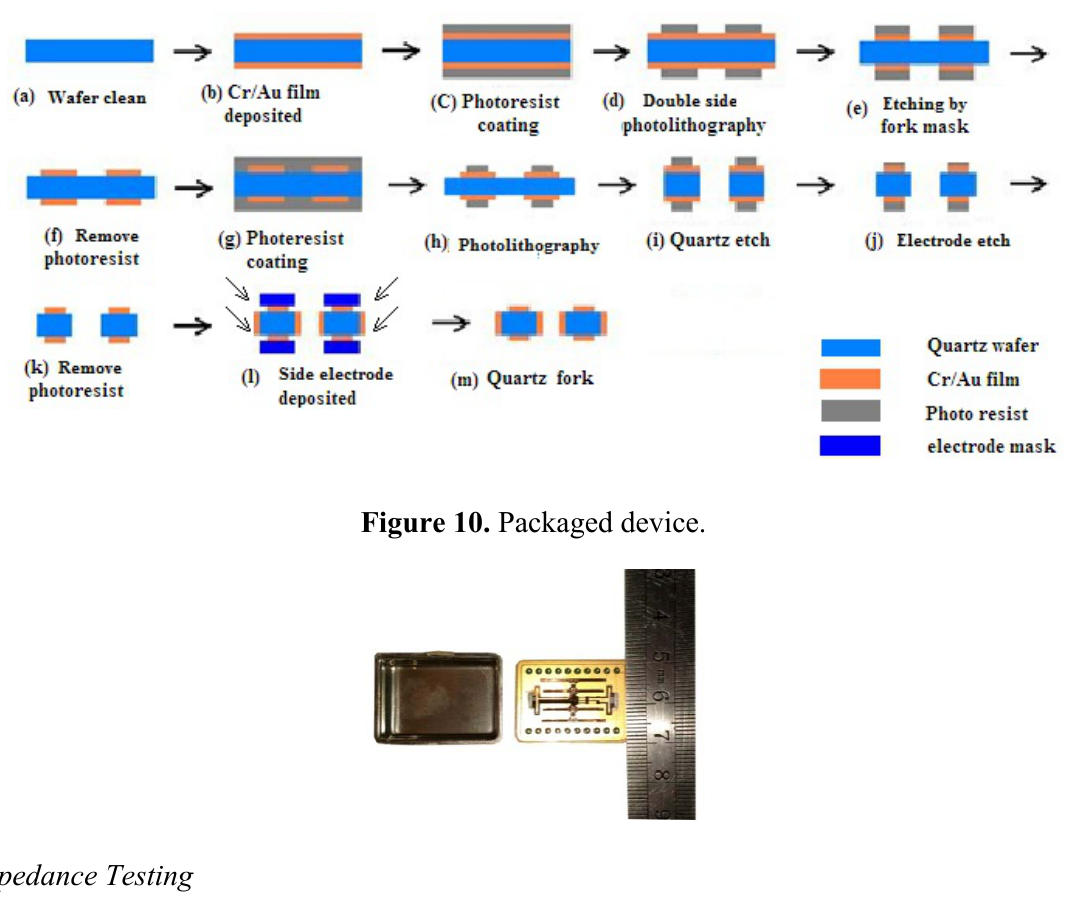
Figure 9. Fabrication process.